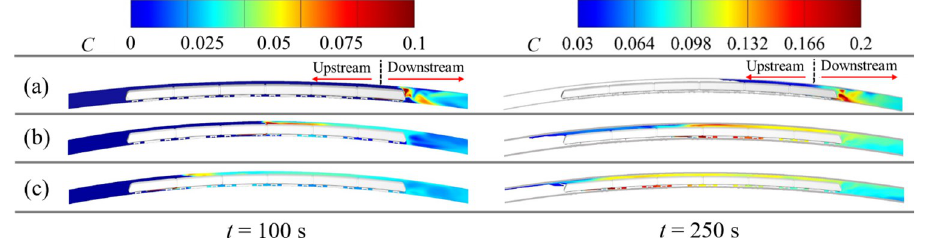
Fig 14. Smoke concentrations for different fire locations. (a) Head car; (b) middle car; (c) tail car.